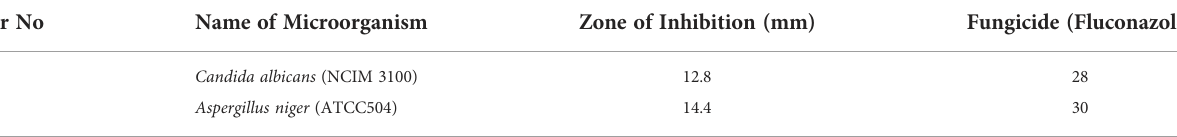
TABLE 4 Antifungal activity of Sargassum extract (Concentration of the sample - 1mg/ml).